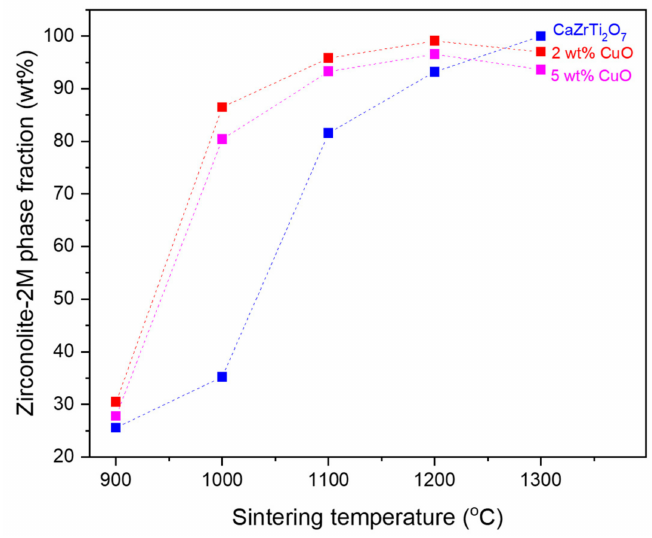
Figure 2. Zirconolite-2M phase fractions obtained from Rietveld analysis of powder XRD